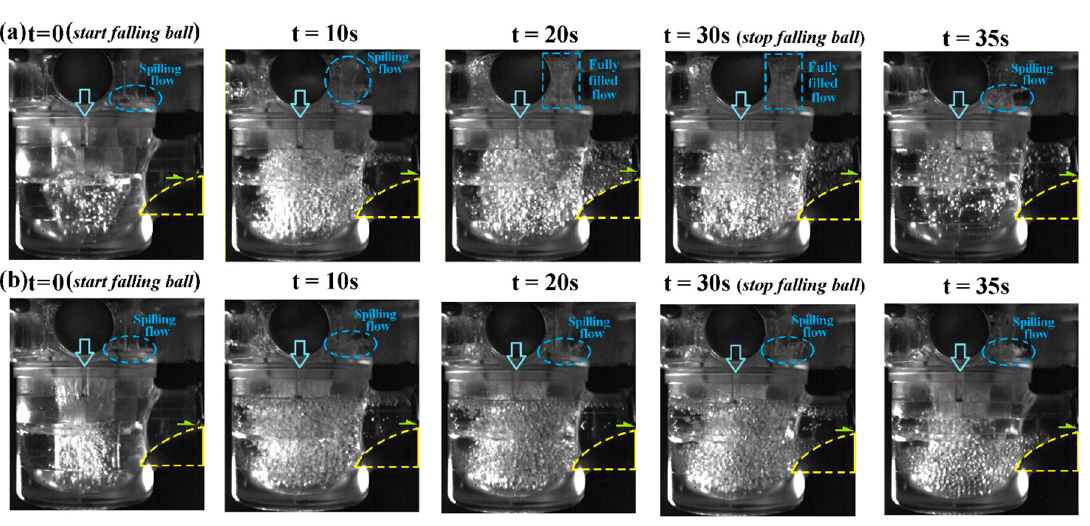
Figure 9. Flow snapshots for glass ball transportation through gullies with: ( a ) beveled; and ( b ) downward nozzle flows at 0.8L/s.